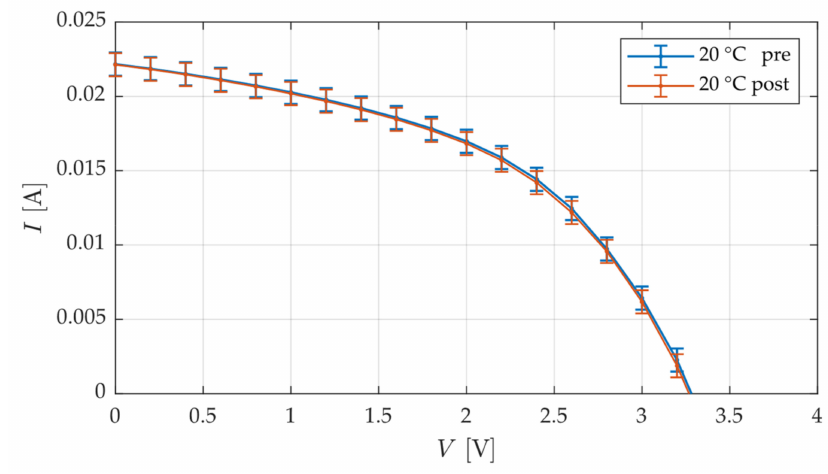
Figure 15. I-V characteristic of a material demonstrator of material combination 1 (see Figure 13) before and after atomic oxygen exposure.